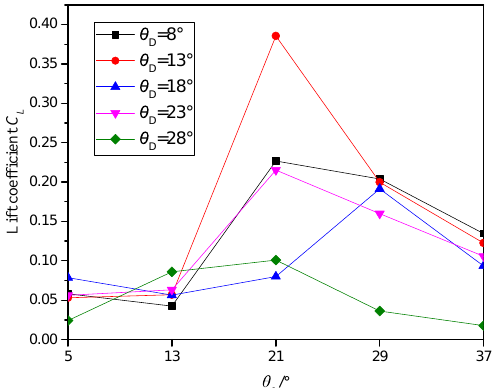
Figure 9. Variation of lift coefficient around AUH model versus different design parameters θ C and θ D